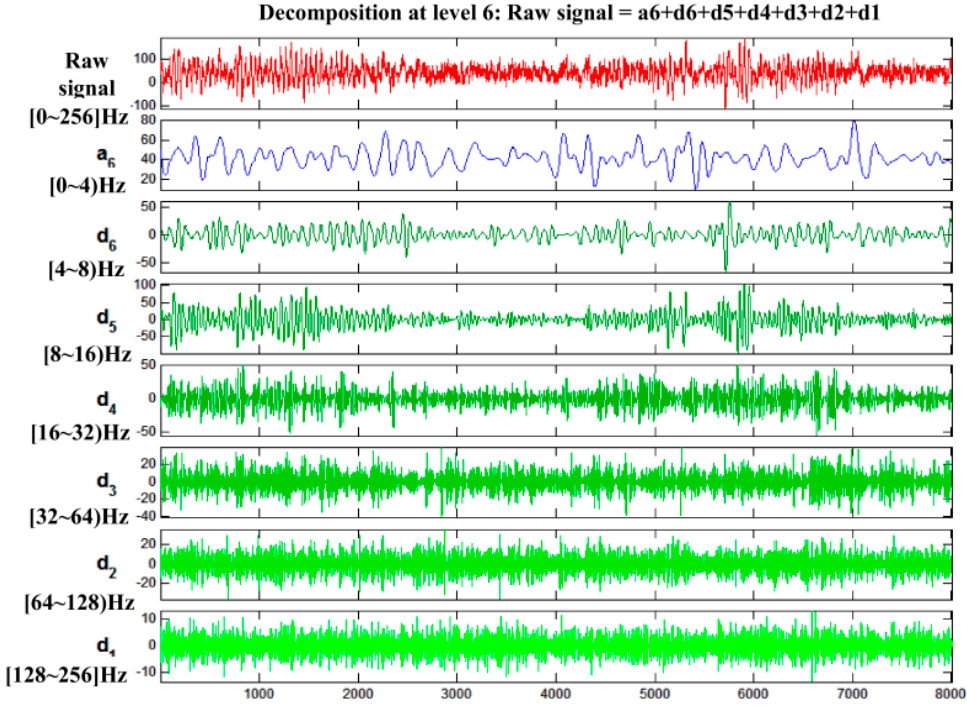
Figure 14. Original signal and its decomposition at each level.